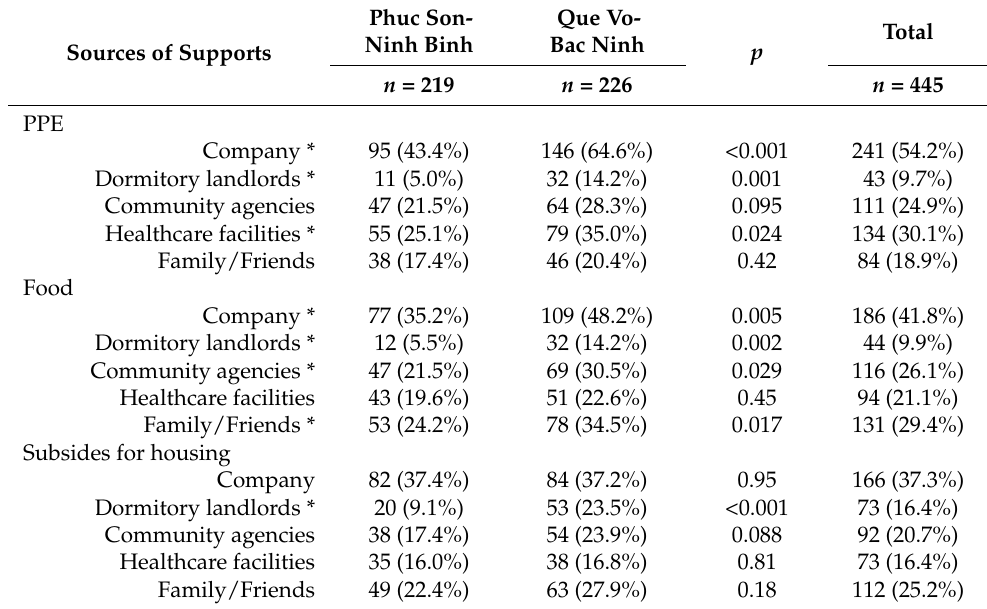
Table 8. Support given to migrant workers during COVID-19 from various